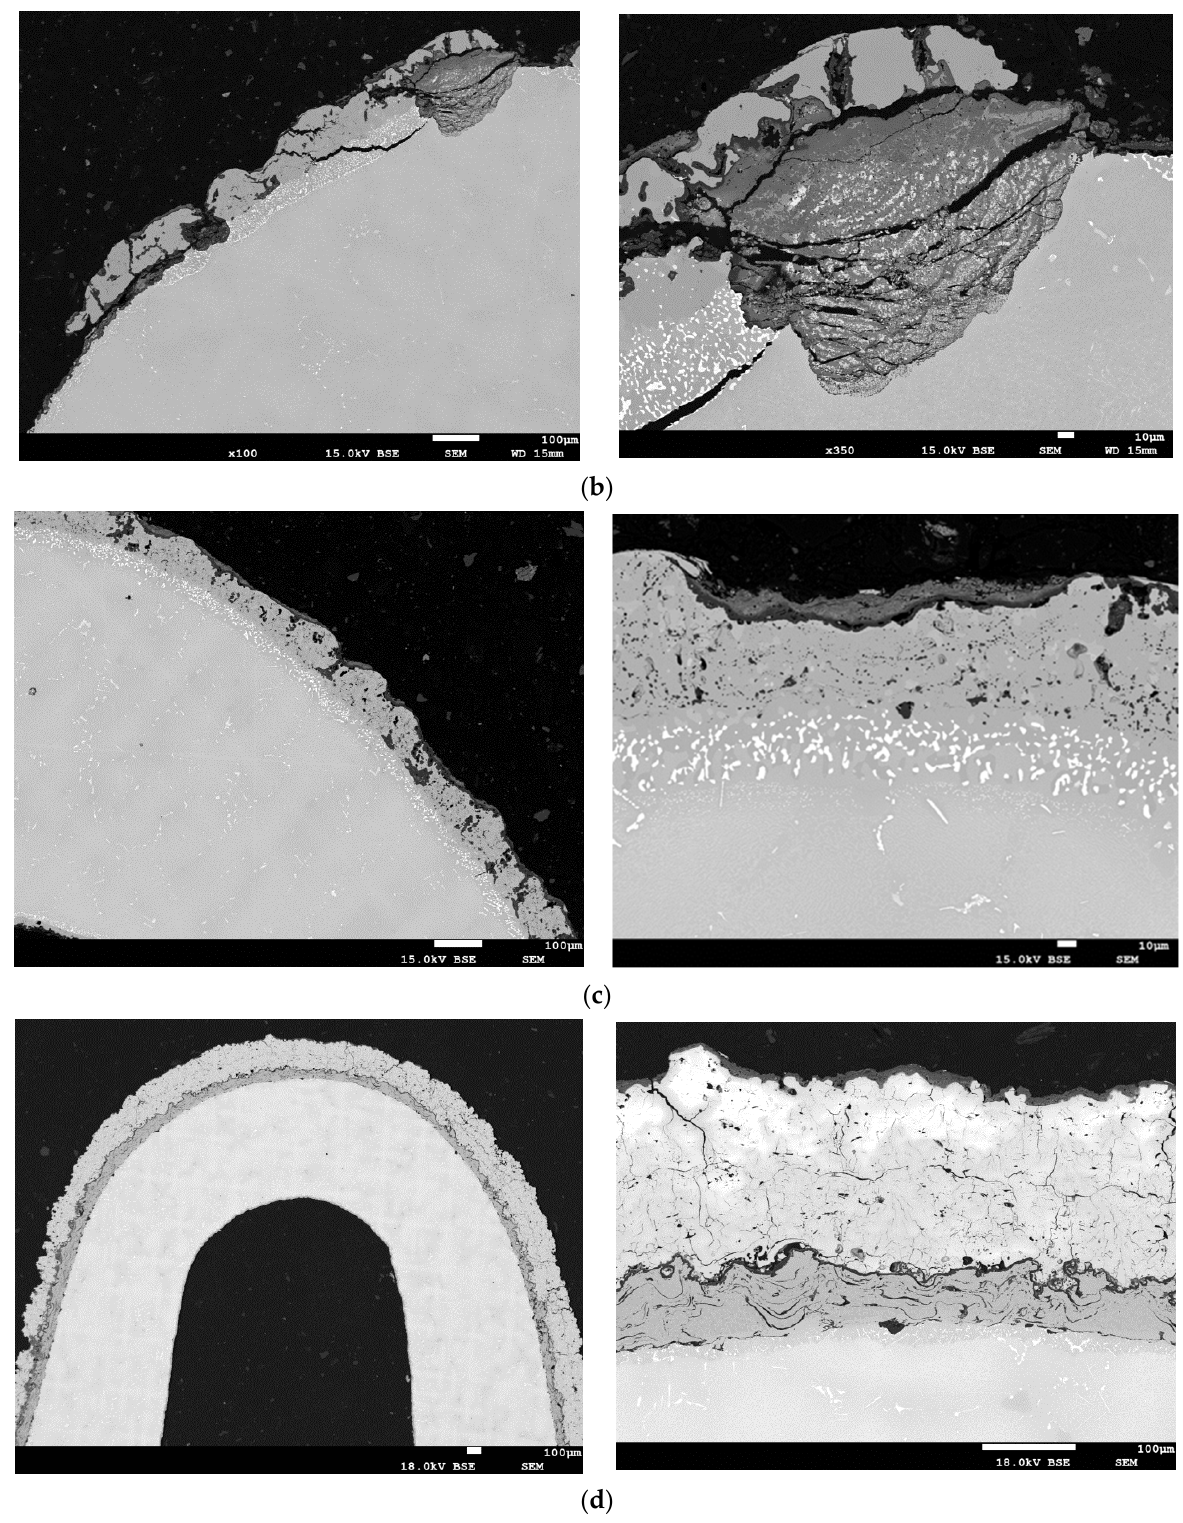
Figure 14. The structure of the protective coatings in the blade cross-section A–A (see Figure 2) made by the methods: ( a ) APS; ( b ) APS + SLURRY; ( c ) APS + VPA; ( d ) APS + TBC.